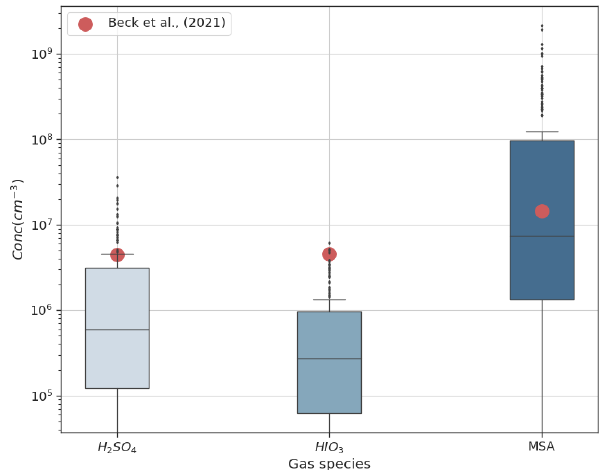
Figure 3. Median particle number size distribution at Gruvebadet and Zeppelin for both modeled (BaseCase simulations) and mea- sured values. The shaded areas indicate the 25th and 75th per- centiles for both model and measured median particle number size distribution. At Zeppelin, the simulated median size distribution is calculated for periods only when SMPS data were available.